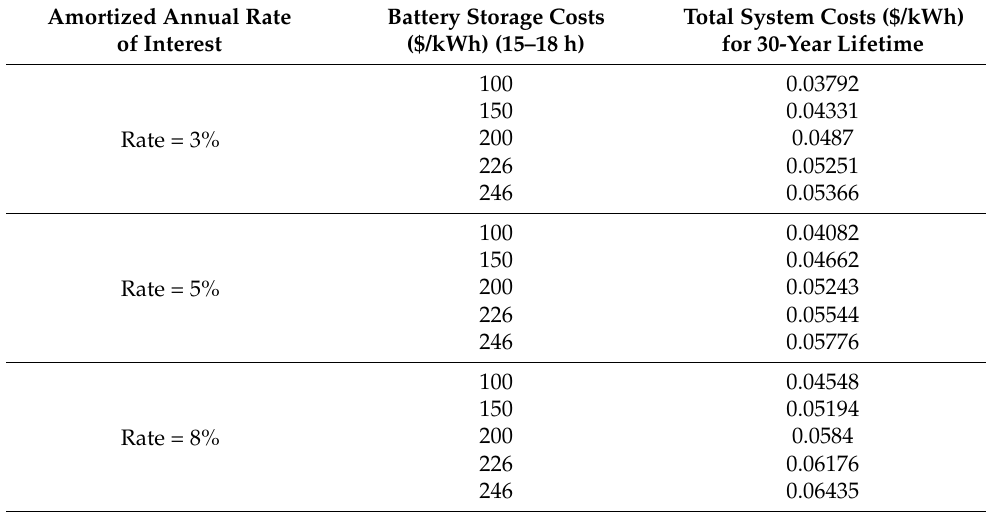
Table 2. Calculated net system cost with varying battery storage costs and rate of